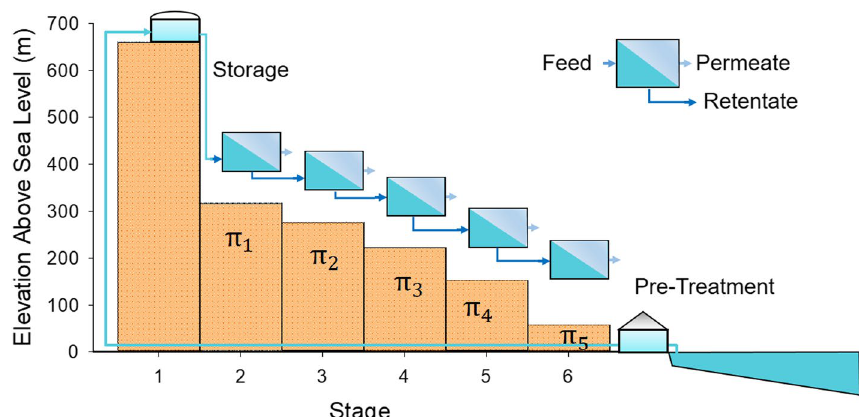
Fig. 4 Arrangement of the five- stage distributed gravity-driven RO stages located on different elevations that correspond to demand sites. This distributed RO can be implemented at a location such as in Fig. 3(b). The pressure of the feed at each stage is 𝜋 1 , 𝜋 2 , 𝜋 3 , 𝜋 4 , and 𝜋 5 = 1.11, 1.25, 1.43, 1.67, and 2.00 𝜋 0 , respectively. The feed for the 6 th stage at sea level with pressure 𝜋 6 comes from the PX device used to recover the energy in the brine and transfer that energy to treated